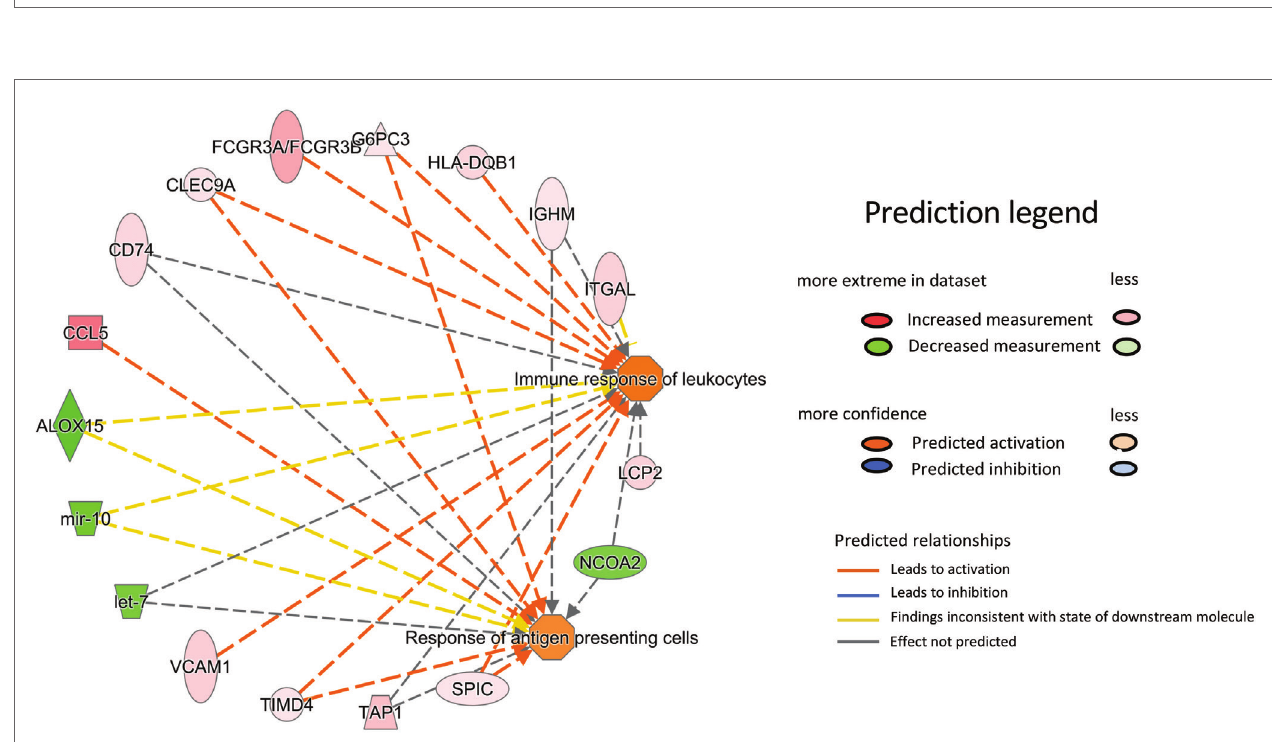
FigUre 8 | Ingenuity Pathway Analysis network representation of two prominently overrepresented pathways in the epididymis of the Tgfbr2 Δ DC mice with high relevance to the model of autoimmunity: response of antigen-presenting cells ( p = 4.17E − 005) and immune response of leukocytes ( p = 2.5E − 005). The relationship and direction of change are indicated as upregulated in Cre + (shades of red) or downregulated in Cre + (shades of